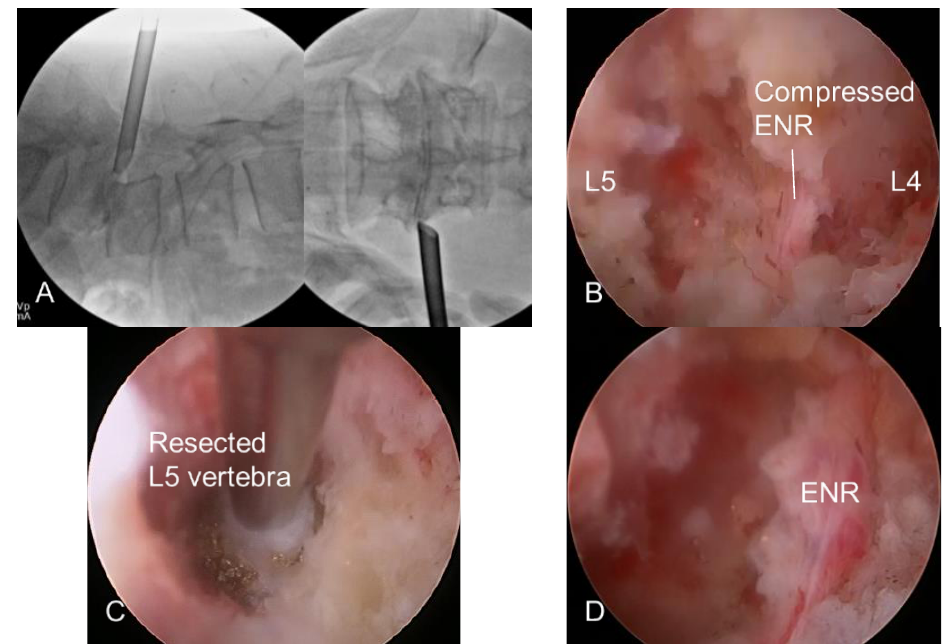
Figure 2. Intraoperative fluoroscopic and endoscopic views. ( A ) Foraminal docking of the working sheath. ( B ) Initial endoscopic view. Note the exiting nerve root (ENR) compressing by the surrounding bone and soft tissues. ( C ) Foraminal unroofing with the removal of bony structures including the lower vertebral endplate compressing the ENR. ( D ) At the final view, the ENR was freely released along the entire route of the nerve